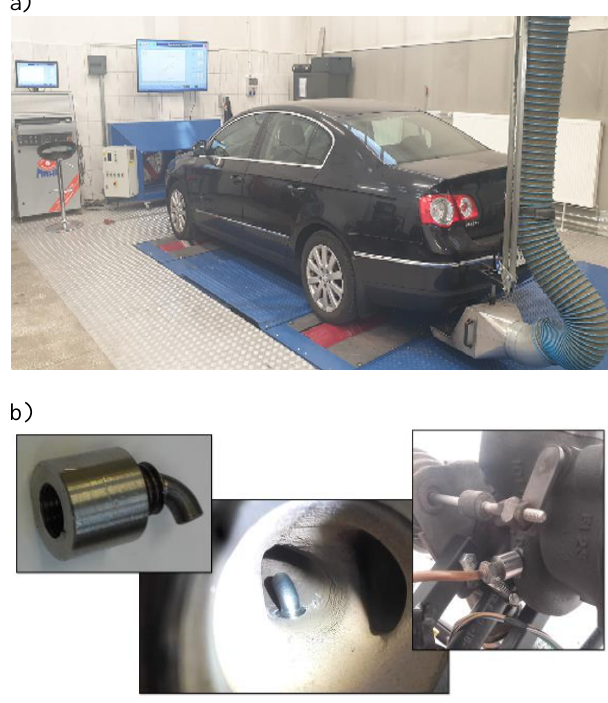
Fig. 2. Test car with a modified supercharging system: a) test vehicle, b) turbocharger